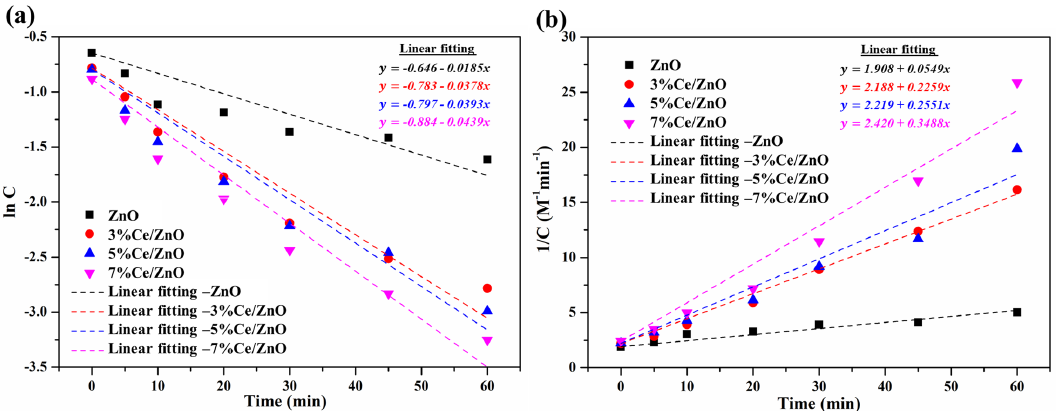
Figure 8. ( a ) First- and ( b ) second-order kinetic adsorption curves of the pristine ZnO and Ce/ZnO catalysts during photodegradation of methyl